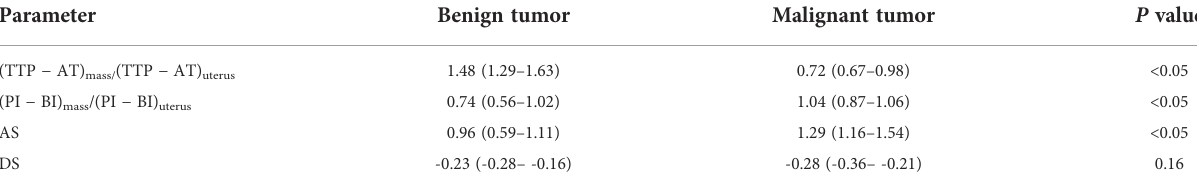
TABLE 3 Comparison of CEU parameters between benign and malignant masses.